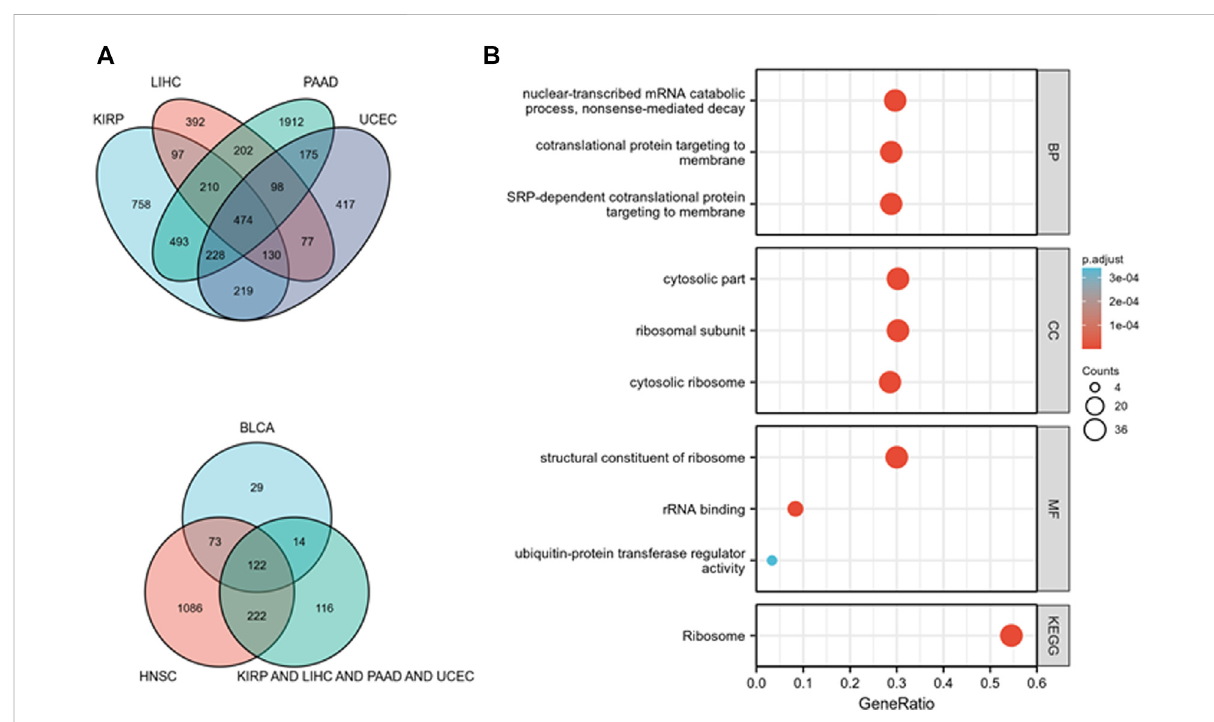
FIGURE 8 TOP1MT functional analysis. (A) Co-expressed genes in BLCA, HNSC, KIPP, PAAD, UCEC, and LIHC tumors; (B) KEGG and GO pathway analysis of co-expressed genes in BLCA, HNSC, KIPP, PAAD, UCEC, and LIHC tumor